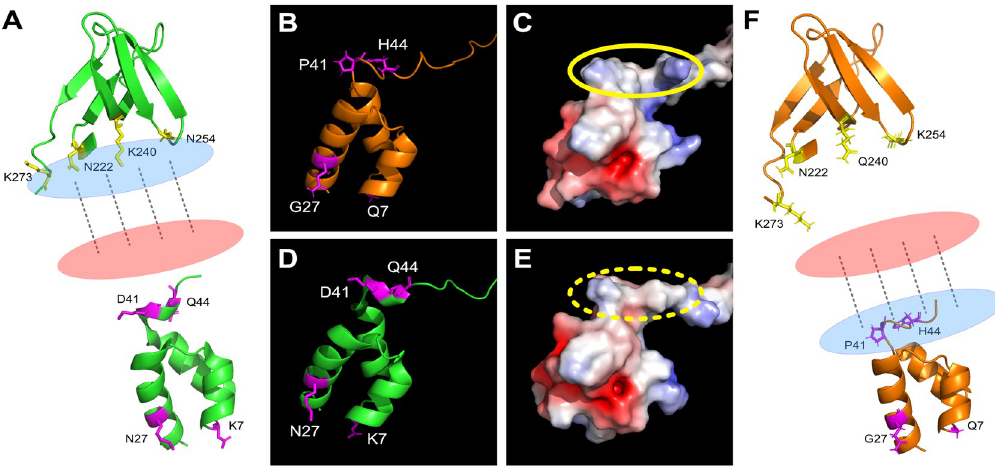
Fig 7. Model for the complementation of the CLA and NOG motifs. ( A ) CTD (220–274) and NTD (1–47) of HIV-1 M IN, PDB 6PUT [21], are shown in green, facing each other. This distribution could happen between two different IN being part of the same intasome. In this case, in the CTD, the CLA motif (in yellow) is forming a positively charged surface (in blue) that is interacting with a negatively charged partner (in red). In magenta are shown the amino acids occupying the NOG positions. ( B ) HIV-1 O NTD (1–47, in orange) with the NOG motif highlighted in magenta. The structure of HIV-1 O NTD was obtained with AlphaFold2. ( C ) Surface electrostatic potential of HIV-1 O NTD (panel B). The yellow circle shows the positive surface exposed by the NOG motif. ( D ) HIV-1 M NTD (1–47, in green) with the amino acids occupying the NOG positions highlighted in magenta. ( E ) Surface electrostatic potential of HIV-1 M NTD (panel D). The yellow dashes are showing the lack of the positive surface found in HIV-1 O NTD. ( F ) HIV-1 IN O CTD (220–274) and NTD (1–47), both obtained with AlphaFold2, are shown in orange, facing each other. Here, the positive surface (in blue) is formed thanks to the presence in the NTD of HIV-1 O IN of the NOG motif (in magenta), interacting with a negatively charged partner (in red). In yellow are shown the amino acids occupying the CLA positions in HIV-1 O IN CTD.